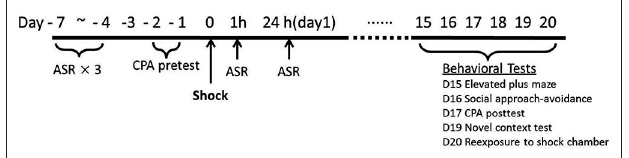
FIGURE 1 | Timeline of stress, startle assessments and PTSD-like behavioral